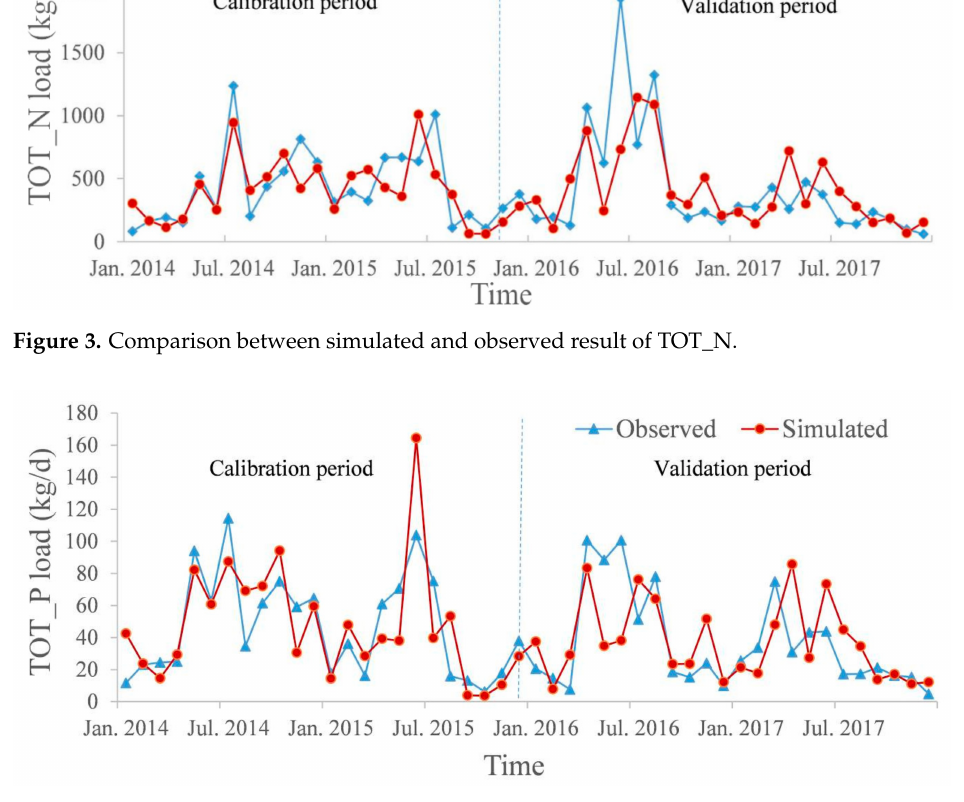
Figure 4. Comparison between simulated and observed result of